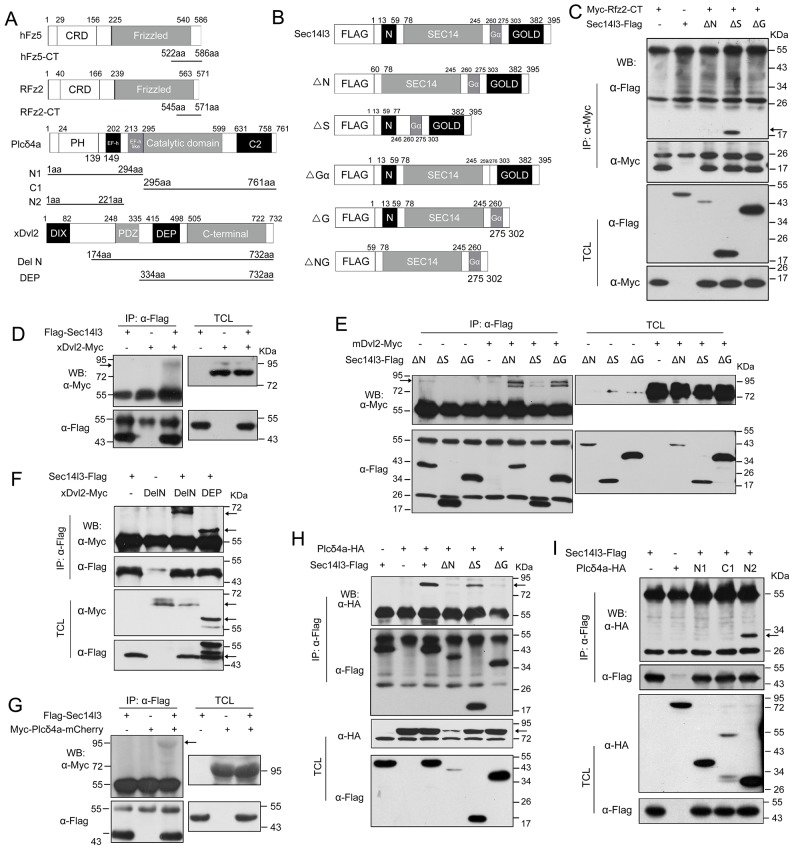
Sec14l3 utilizes distinct domains to interact with Dvl2 and Plcδ4a.(A) Schematic diagrams of truncated forms of hFz5, RFz2, Plcδ4a and xDvl2. Numbers above the diagram indicate the corresponding amino acid positions. hFz5/RFz2 has N terminal CRD (Cysteine-rich Wnt-binding domain) and Frizzled domain (membrane spanning region of frizzled and smoothened factors). Plcδ4a is comprised of Pleckstrin homology (PH) domain, EF-hand (EF-h) domain, EF-hand (EF-h) like domain, Catalytic TIM barrel domain (incorporating regions of high sequence similarity X and Y) and C2 domain. xDvl2 (GeneID: 108703580) possesses DIX domain (named after Dishevelled and Axin), PDZ domain and DEP domain (named after Dishevelled, Egl-10 and Plekstrin). The truncated forms are indicated by respective amino acid positions. (B) Schematic diagrams of Sec14l3 full length form (FL) and truncated mutants. Numbers above the diagram indicate the corresponding amino acid positions. Sec14l3 includes N terminal CARL-TRIO domain (named after cellular retinaldehyde-binding protein (CRALBP) and TRIO guanine exchange factor), medial Sec14 domain (domain in homologues of a S. cerevisiae phosphatidylinositol transfer protein (Sec14p)) and C terminal GOLD domain (short for Golgi Dynamics domain). ΔN, N terminal CARL-TRIO domain deletion;ΔS, Sec14 domain deletion; ΔGα, Gα domain deletion; ΔG, GOLD domain deletion; ΔNG, N-terminal CARL-TRIO domain and C-terminal GOLD domain deletion. (C) Sec14l3 interacts with Rfz2-CT via its CARL-TRIO and GOLD domains. Domains of Sec14l3 required for interaction with Rfz2-CT in HEK293T cells were tested by co-immunoprecipitation using deletion constructs. TCL, total cell lysate; IP: Immuno-precipitation; WB: western blot. (D) Flag-Sec14l3 interacts with xDvl2-Myc in zebrafish embryos. Embryos were injected with a mixture of 300 pg Flag-Sec14l3 and 200 pg xDvl2-Myc mRNA at 1 cell stage and lysed at 75% epiboly stage for Co-IP assays. (E) Sec14l3 interacts with mDvl2 via its Sec14 domain. (F) xDvl2 interacts with Sec14l3 via its C-terminal region. (G) Flag-Sec14l3 interacts with Myc-Plcδ4a-mCherry in zebrafish embryos. A mixture of 300 pg Flag-Sec14l3 and 200 pg Myc-Plcδ4a-mCherry mRNA was injected into embryos for Co-IP assays. (H) The Sec14l3 CARL-TRIO and GOLD domains interact with Plcδ4a. (I) The Plcδ4a interacts with Sec14l3 via its N-terminal domain.